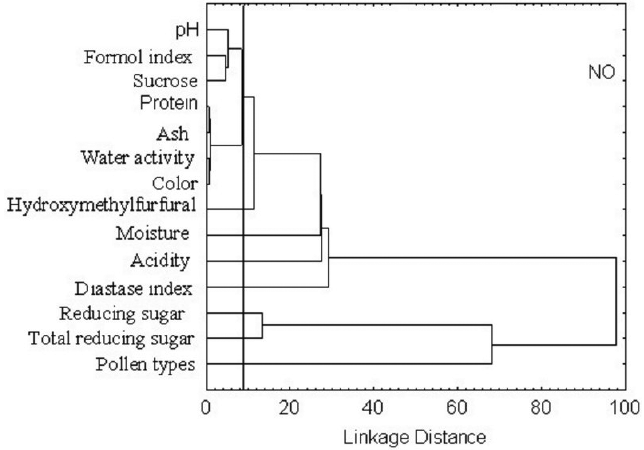
Fig. 2 – Phenogram obtained through the grouping analysis, using the medium Euclidean distance for non-organic honey samples of A. mellifera and physicochemical parameters